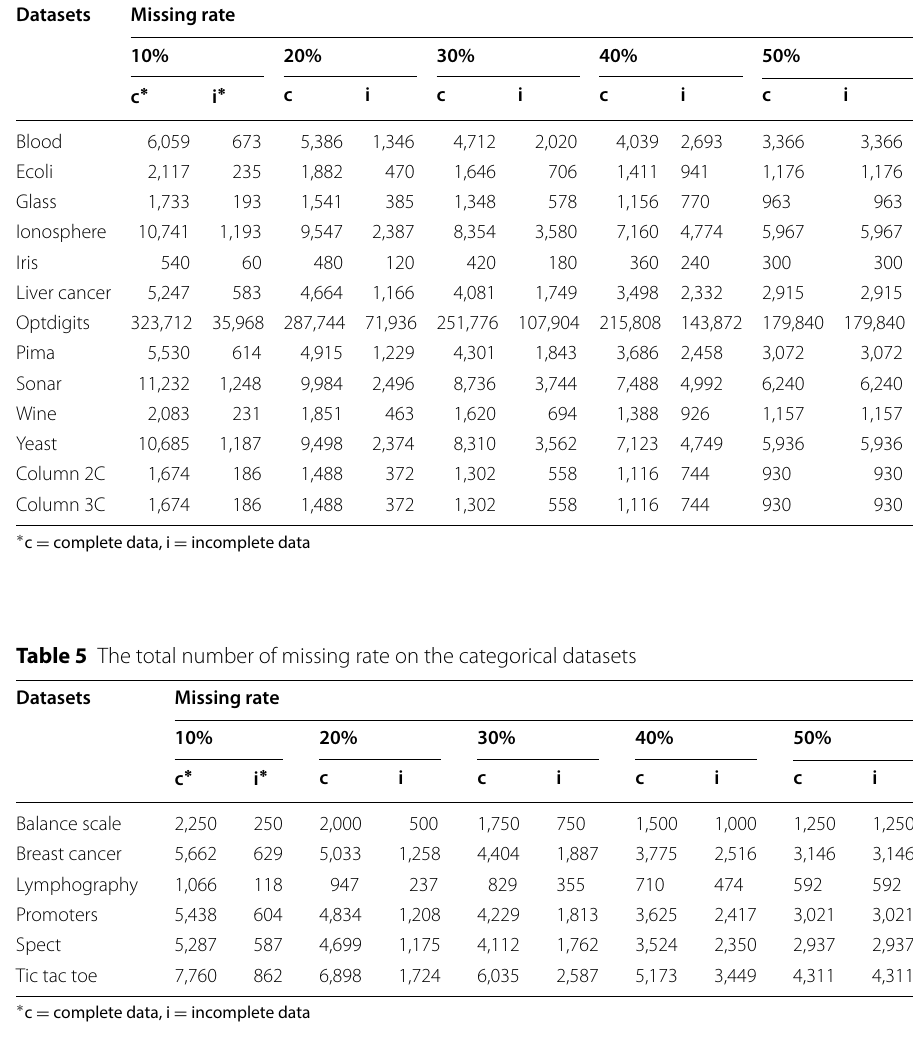
Table 4 The total number of missing rate on the numerical datasets Datasets